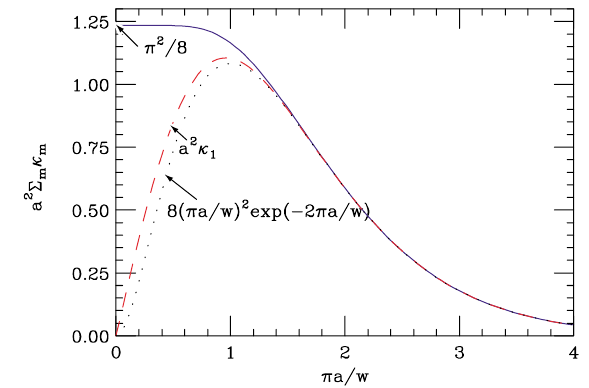
(cid:4) [ (cid:7) m m (dashed line), and 1